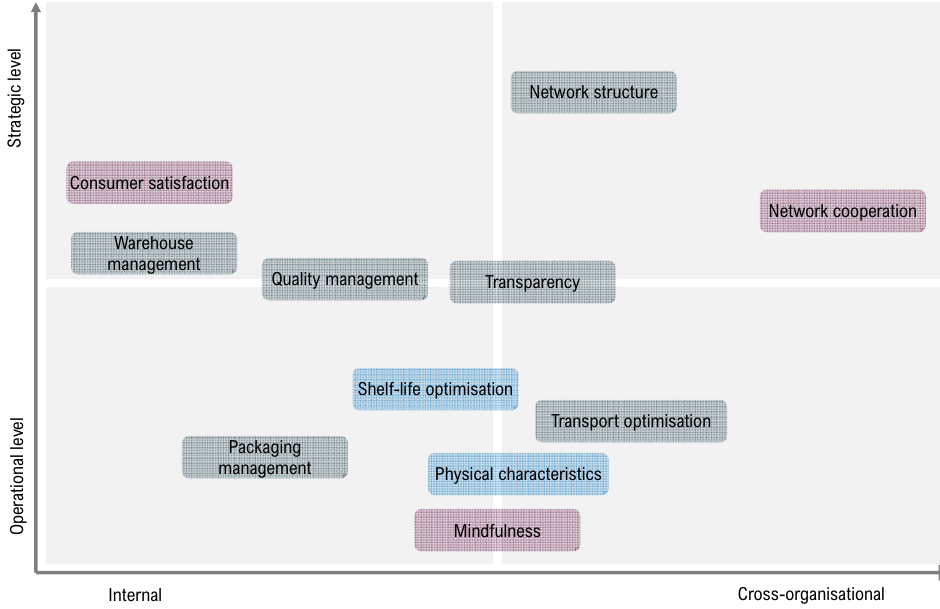
Figure 1. Classification of the fields of action according to application and company level [22].